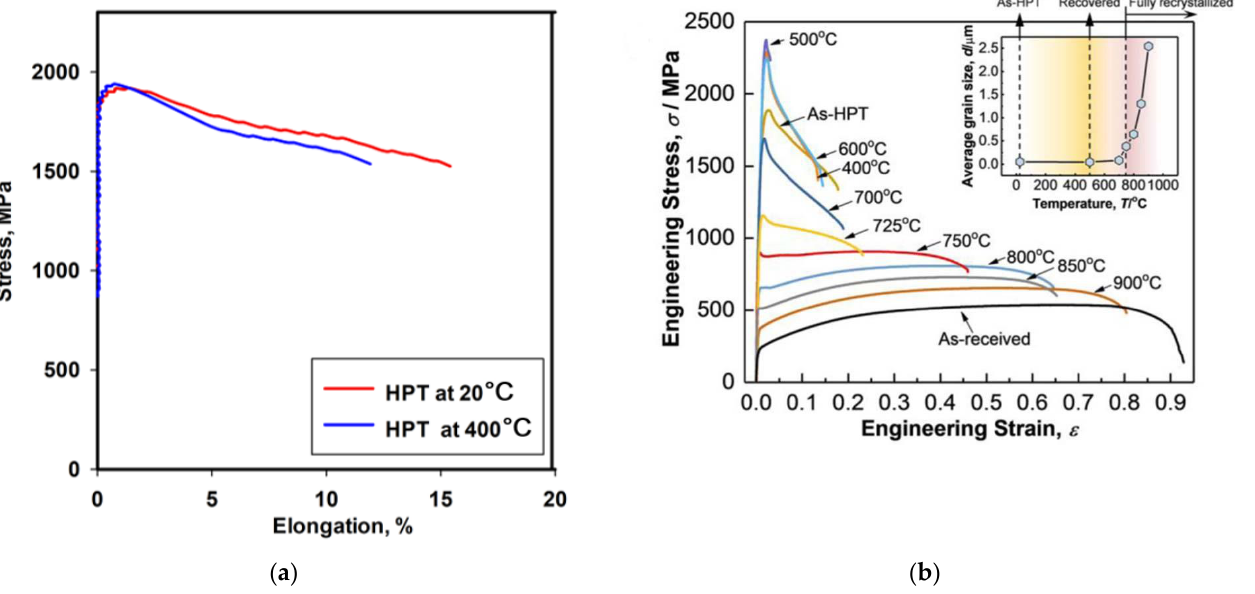
Figure 32. Engineering stress – strain curves for UFG 304-type steel obtained by HPT at indicated temperatures ( a ) and those for UFG 316-type steel processed by HPT and subsequent annealing at indicated temperatures (b) [119]. Reproduced from [119] with permission from Elsevier, 2023.